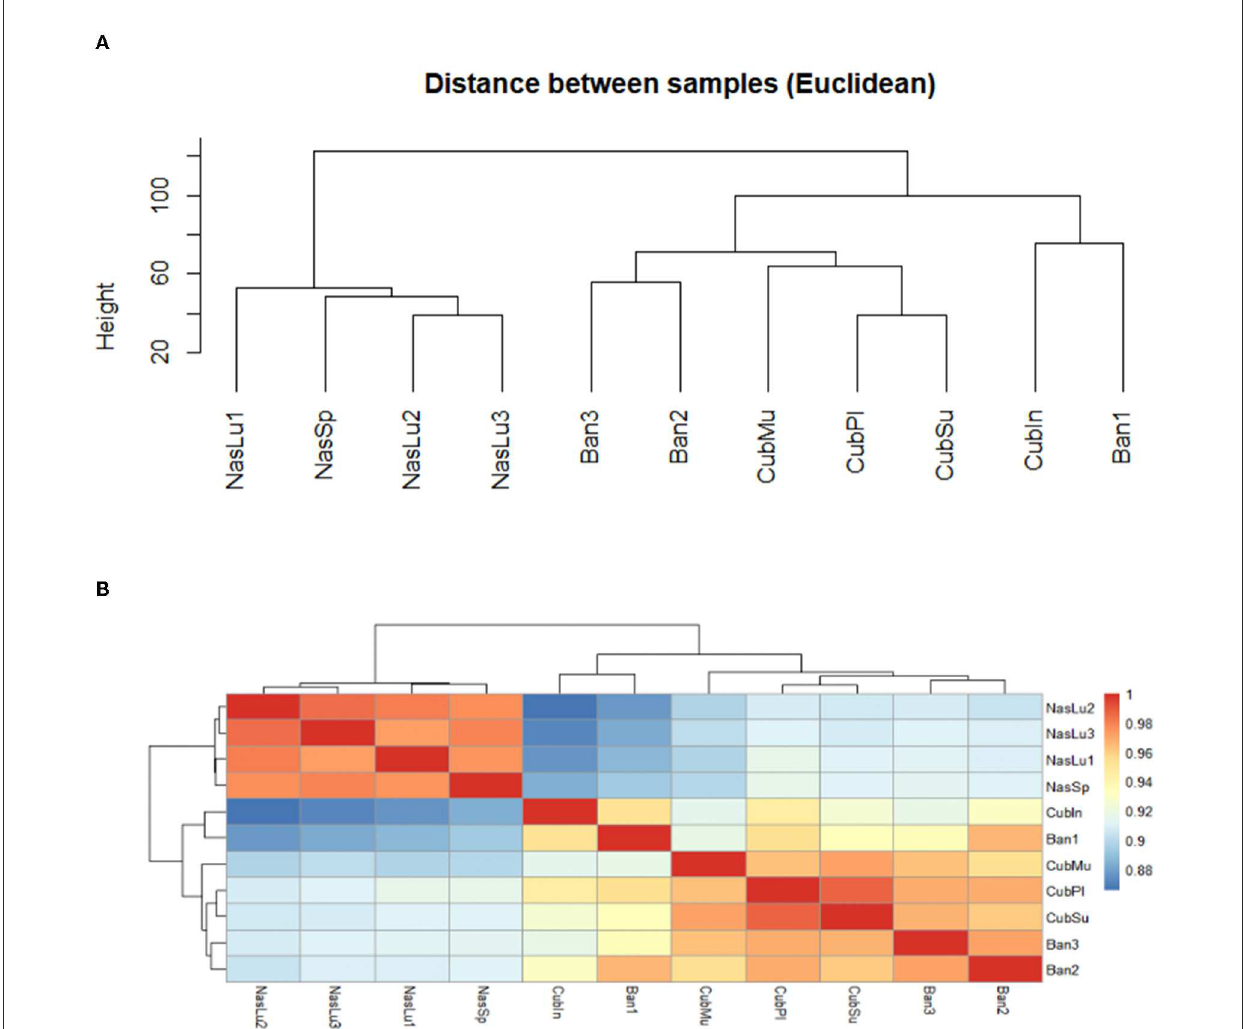
FIGURE9 PFAM hierarchical clustering of samples. (A) Hierarchical clustering according to Euclidean distance. (B) Hierarchical clustering represented by means of a